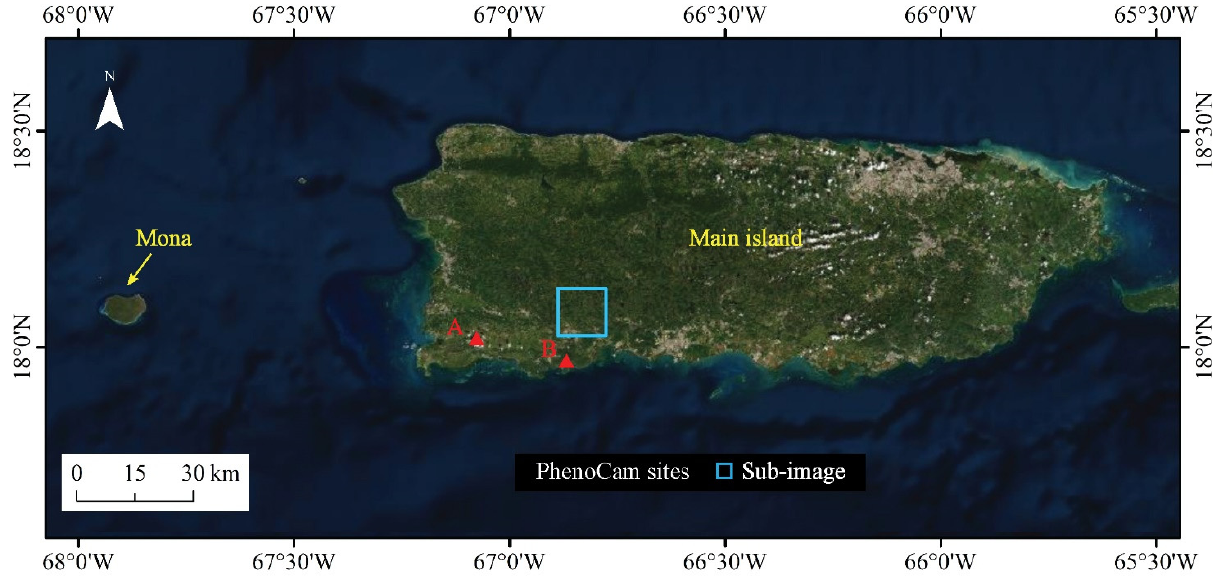
Figure 1. Map of the study area showing the main island and Mona island of Puerto Rico, and the location of two PhenoCam sites and a sub-image that were used to validate the results of this study.